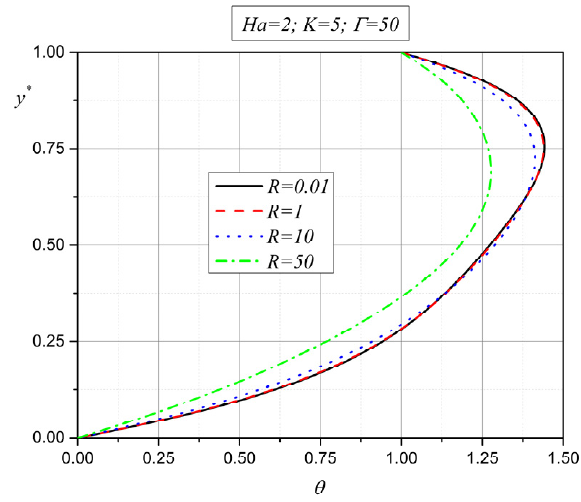
Figure 16. Dimensionless temperature 𝜃 for different values of porosity parameter 𝑅 .